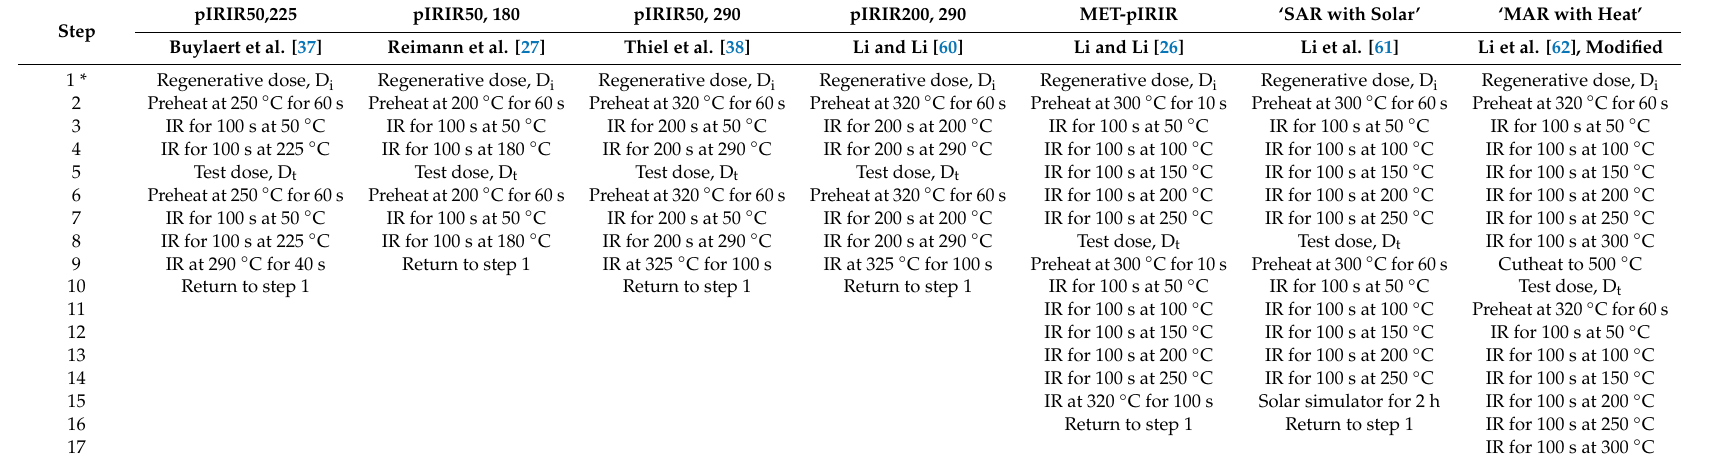
Table 1. Di ff erent pIRIR protocols: pIRIR 50, 225 ; pIRIR 50, 180 ; pIRIR 50, 290 ; pIRIR 200, 290 ; MET-pIRIR; ‘SAR with solar’; ‘MAR with